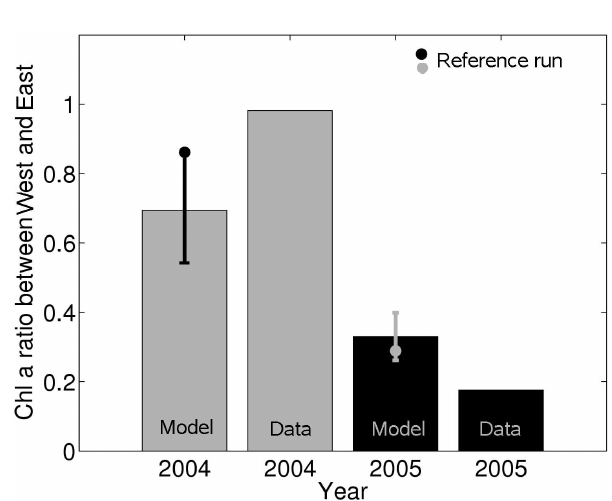
Fig. 4. Sensitivity of model results to the systematic variation of four parameters ( I opt [ 125 ... 225W × m − 2 ] ,